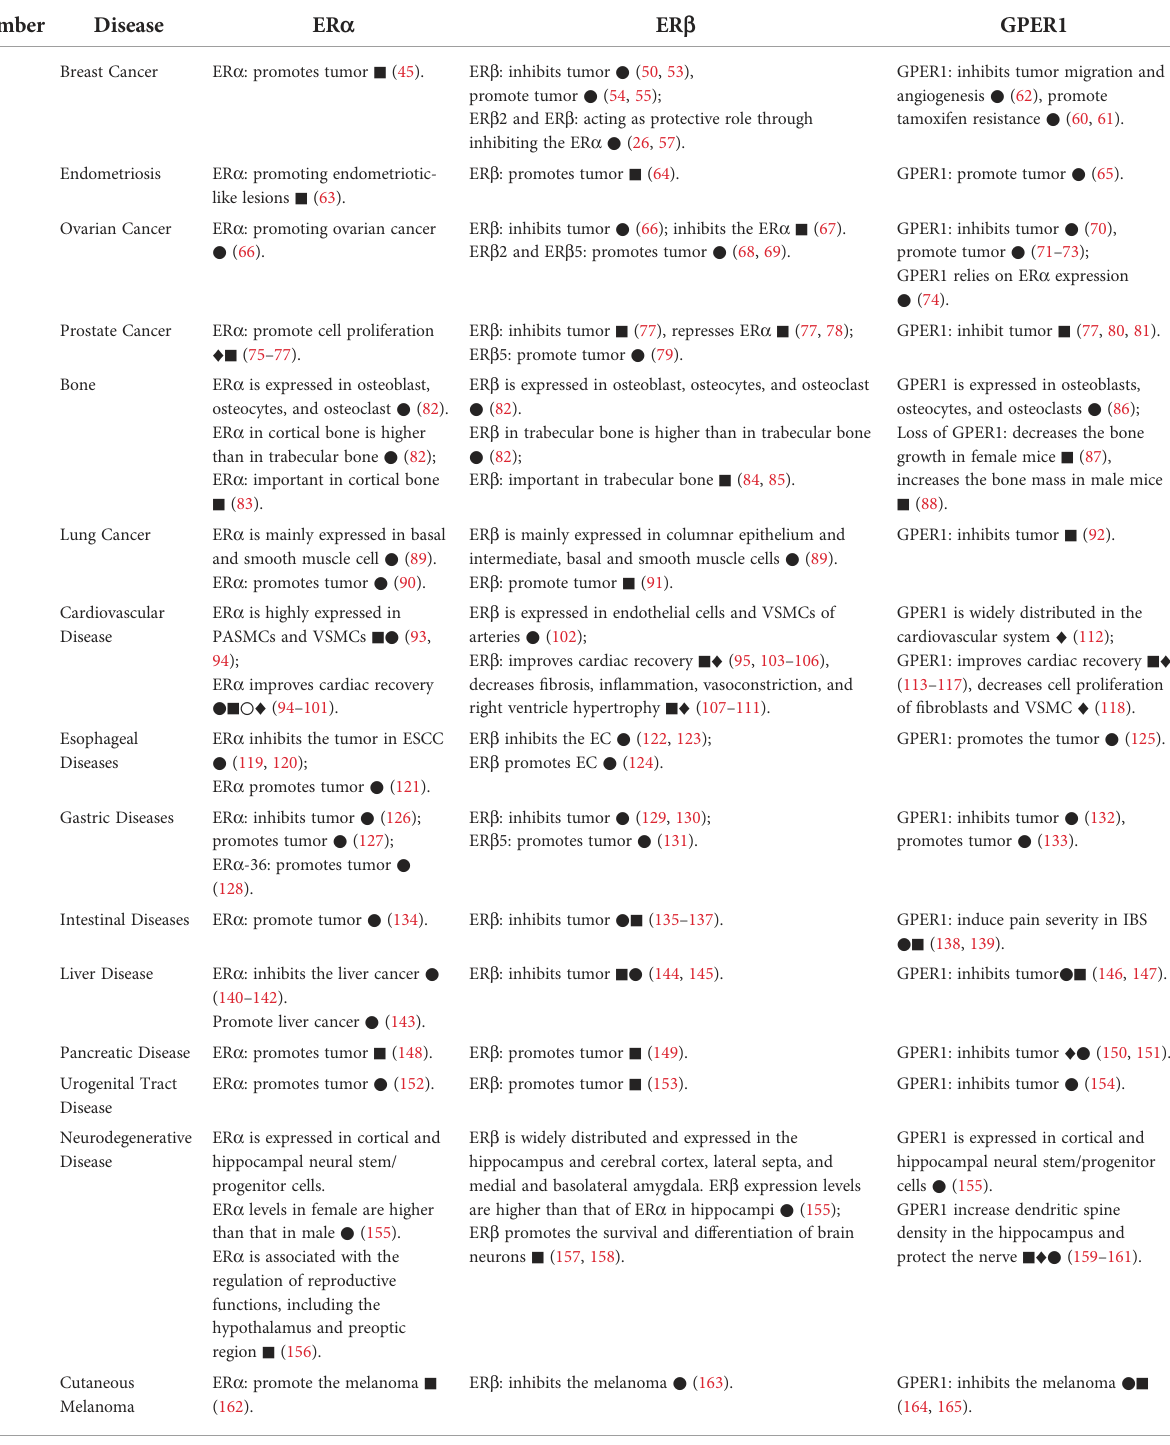
TABLE 1 The role of ERs in various